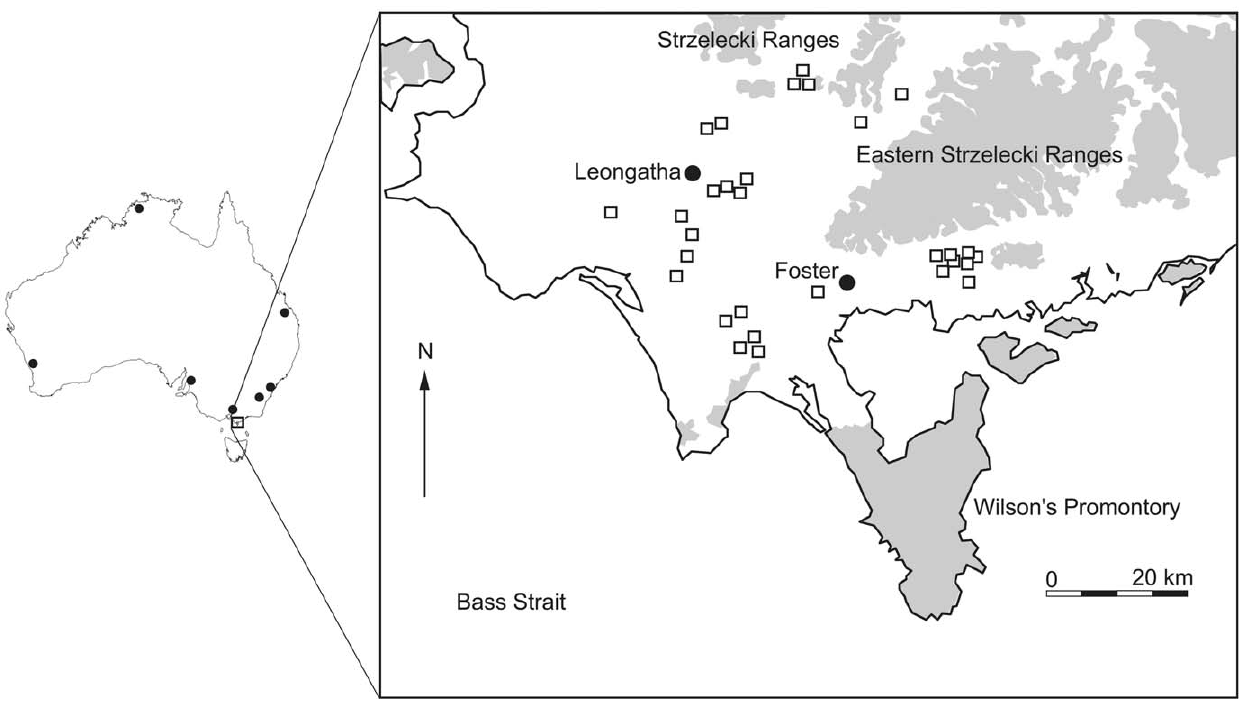
Figure 5. Study region in South Gippsland, south-east Australia. White=cleared agricultural land. Shaded areas=native tree cover (includes native regrowth, old growth forest and native plantations). Approximate locations of fragment study sites are indicated by white boxes ( % ). Map based on DSE interactive forest-explorer online maps (‘Forest-Explorer Online’ maps, http://www.dse.vic.gov.au).